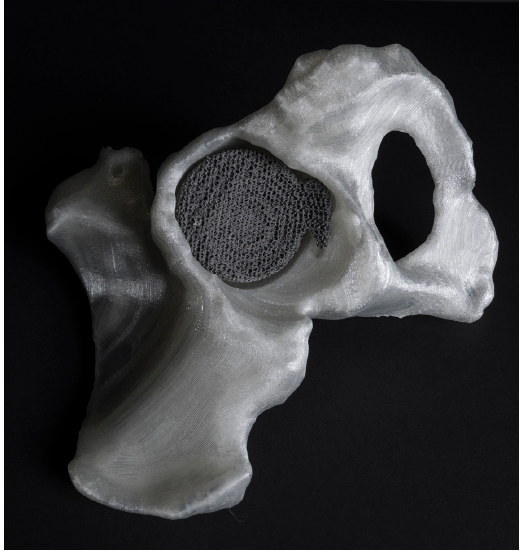
Figure 1. A patient-specific implant designed based on computed-tomography (CT) images and AM with selective laser melting. The corresponding bone is also segmented from CT images and AM with fused deposition modeling. Made at Additive Manufacturing Lab, TU Delft (Researchers: Eline Kolken and Saber Amin Yavari).